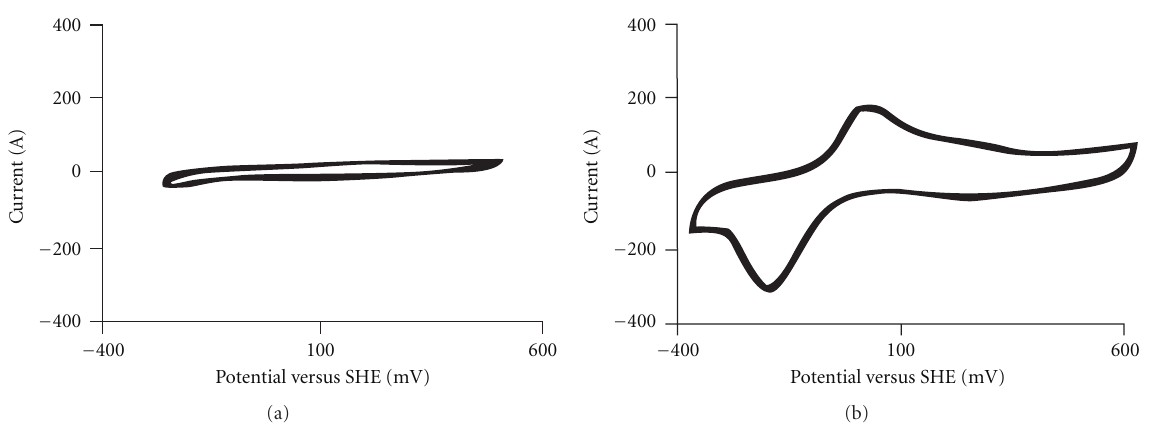
Figure 3: Cyclic voltammograms of ferritin on a 6 cm 2 bare gold electrode. Ferritin equilibrated at zero potential or at − 200 mv, (a). Ferritin adsorbed at +500 mv, (b). The voltage was cycled at 100 mV/s in 0.05 M MOPS pH 7 with 0.05mM TGA as promoter.